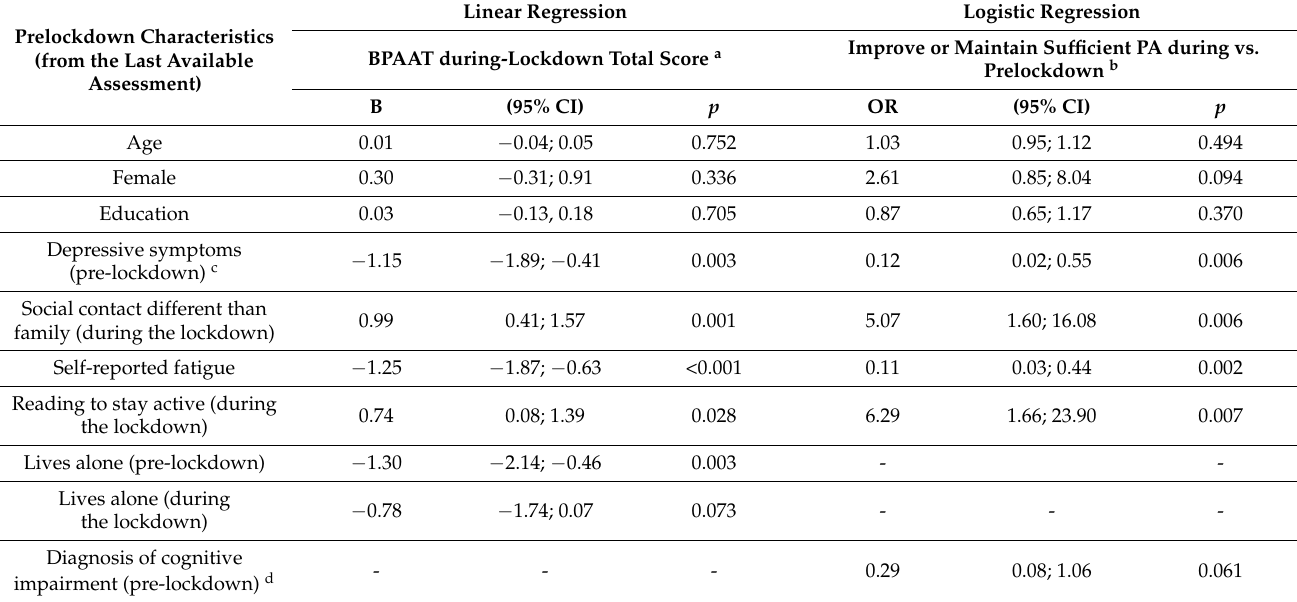
Table 3. Association of pre-lockdown characteristics and total physical activity a during the lockdown or pre-post improve- ment or maintenance of sufficient physical activity a